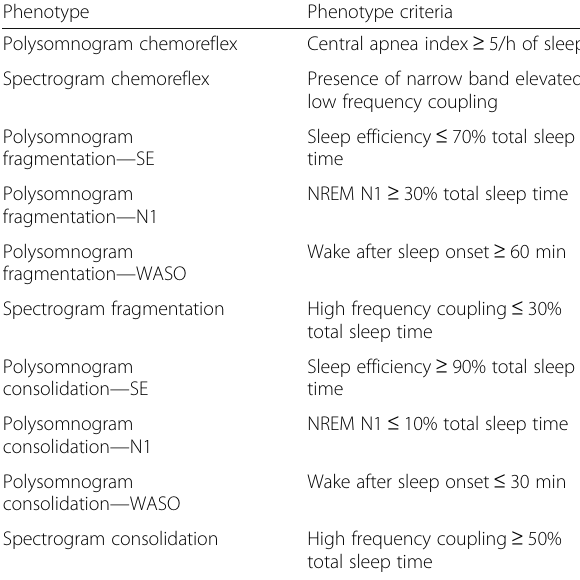
Table 1 Phenotype